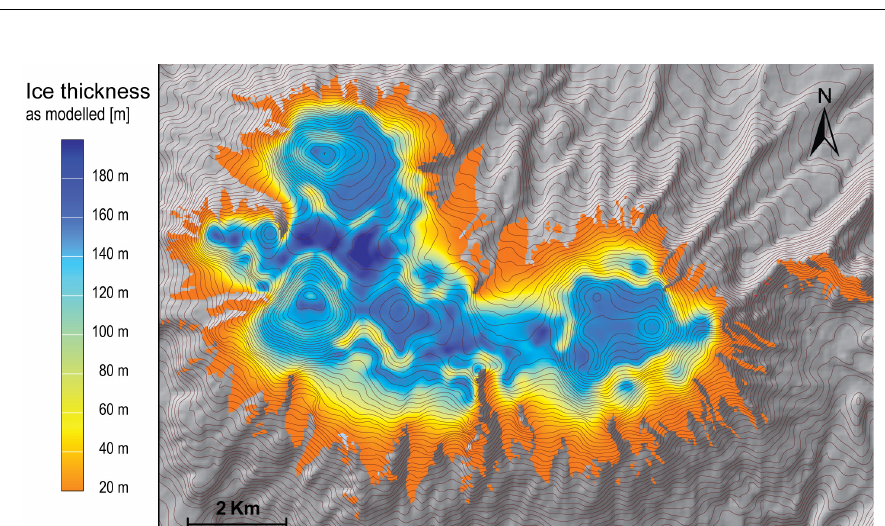
Fig. 10. Estimation of ice thickness